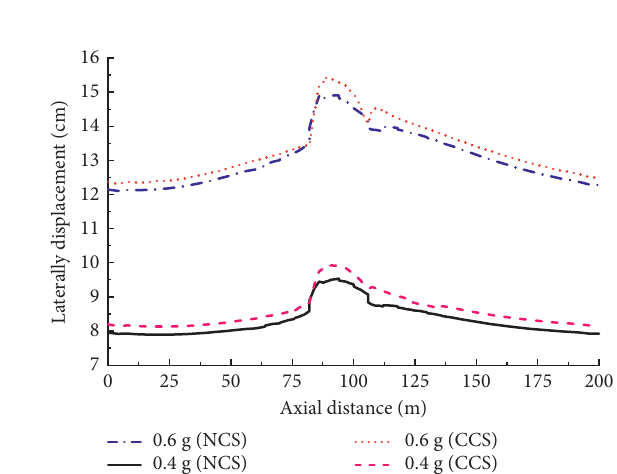
Figure 16: Laterally displacement of the footwall under different seismic intensities.